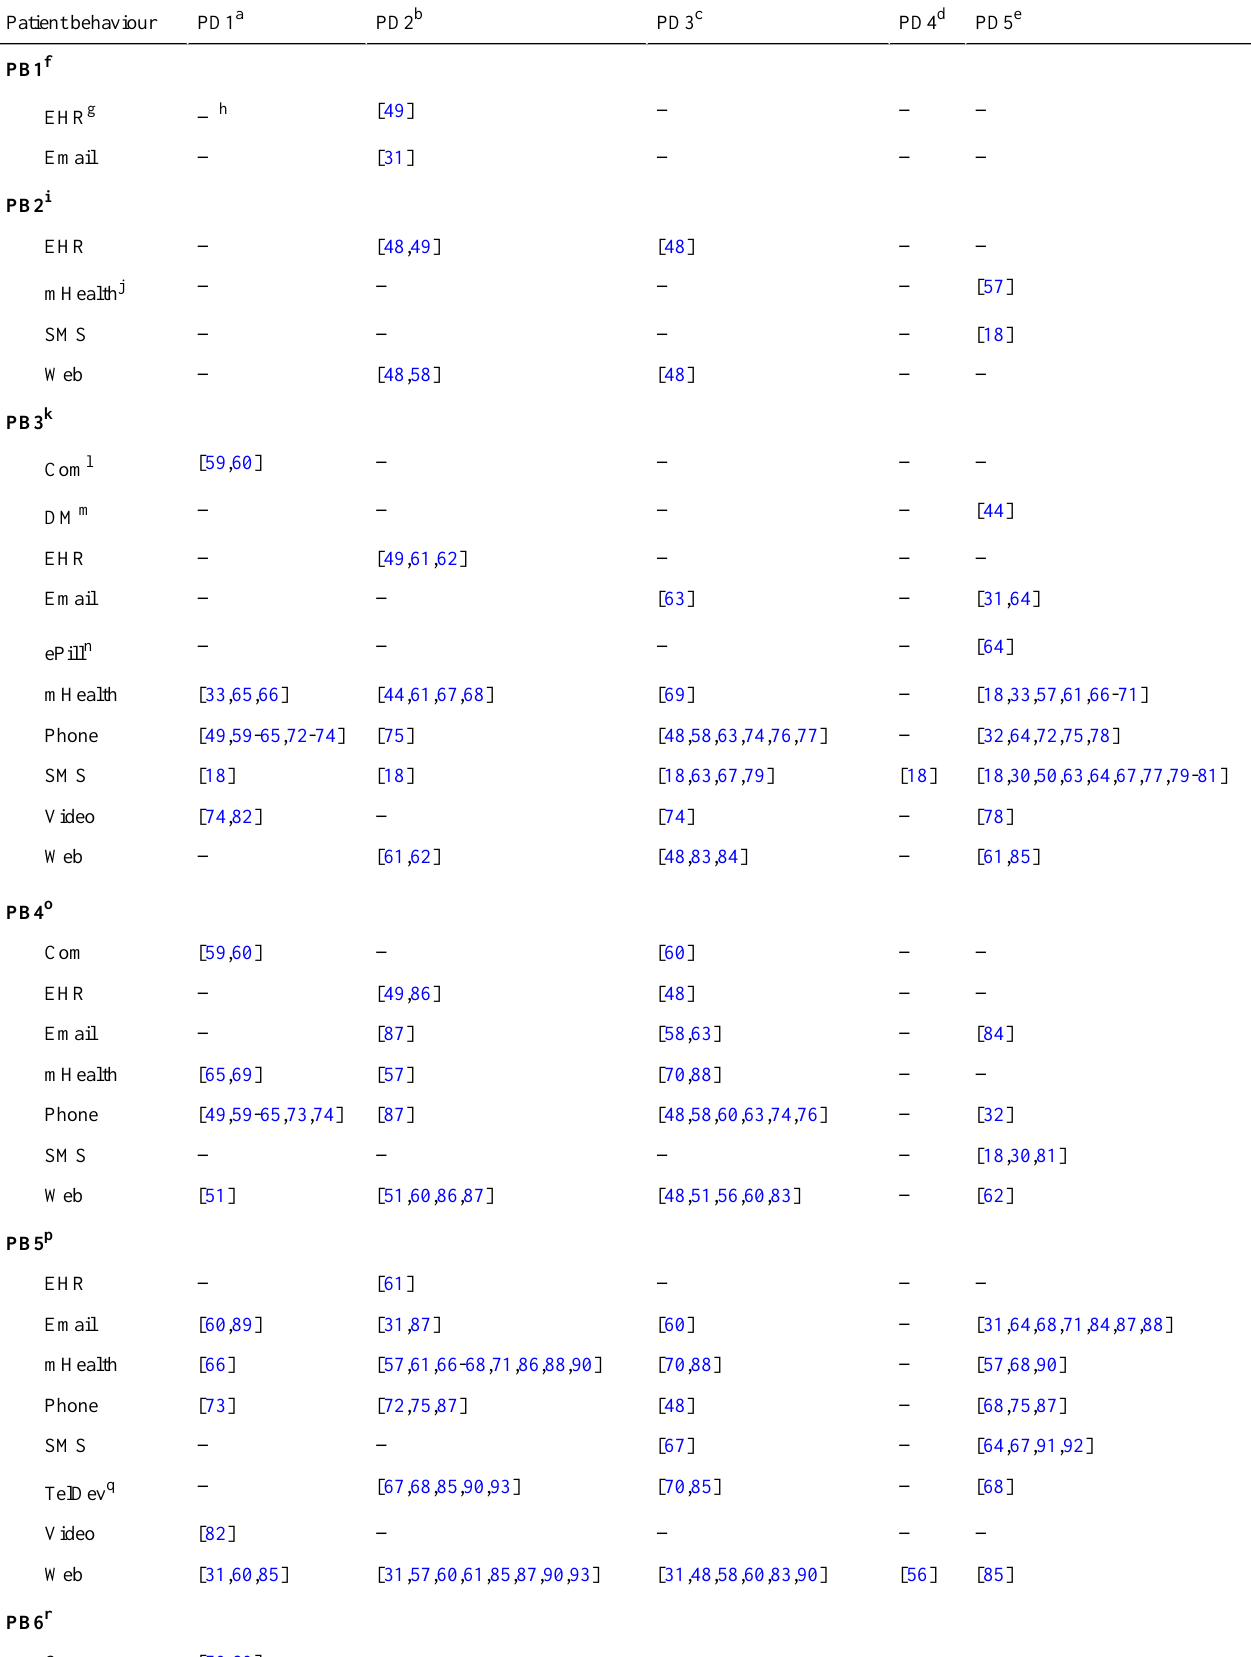
Table 1. Matrix of change objectives at the patient level, with the studies targeting medication adherence or blood pressure improvement in patients with hypertension categorized by digital intervention delivery